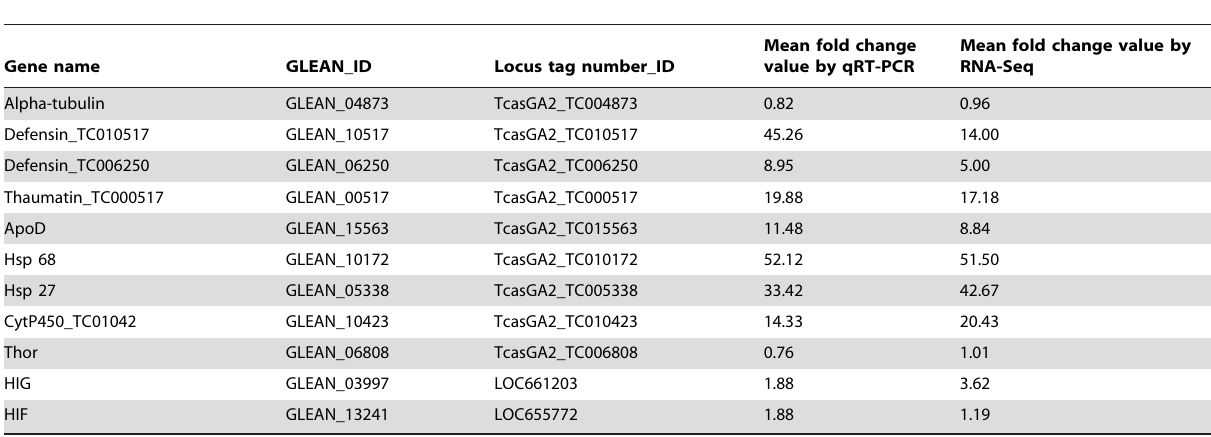
Table 2. Comparison of RNA level estimation by our recent qRT-PCR analysis [12] and present transcriptome sequencing approach.